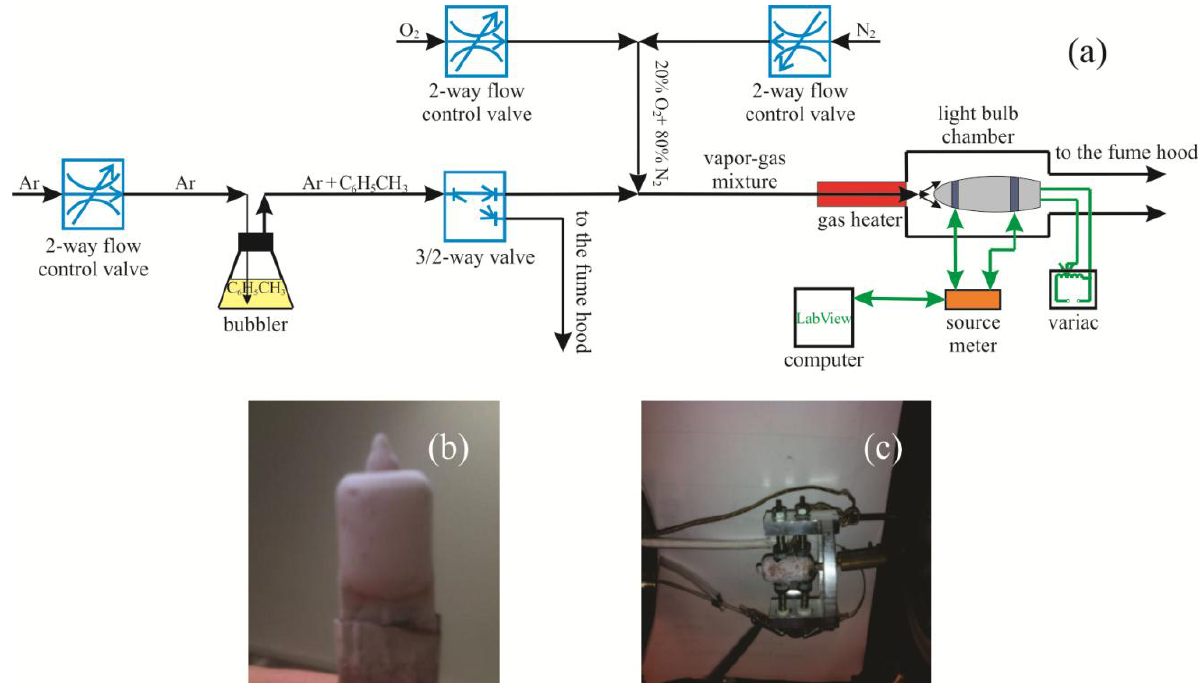
Figure 2. ( a ) A schematic of the experimental setup used to acquire electrical response of the xenon light bulb chemiresistor; ( b ) the xenon light bulb sensor; and ( c ) the light bulb sensor mounted in the